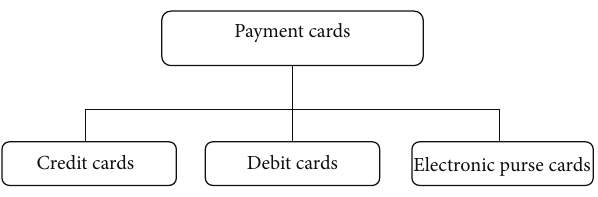
Figure 2: Classification of payment